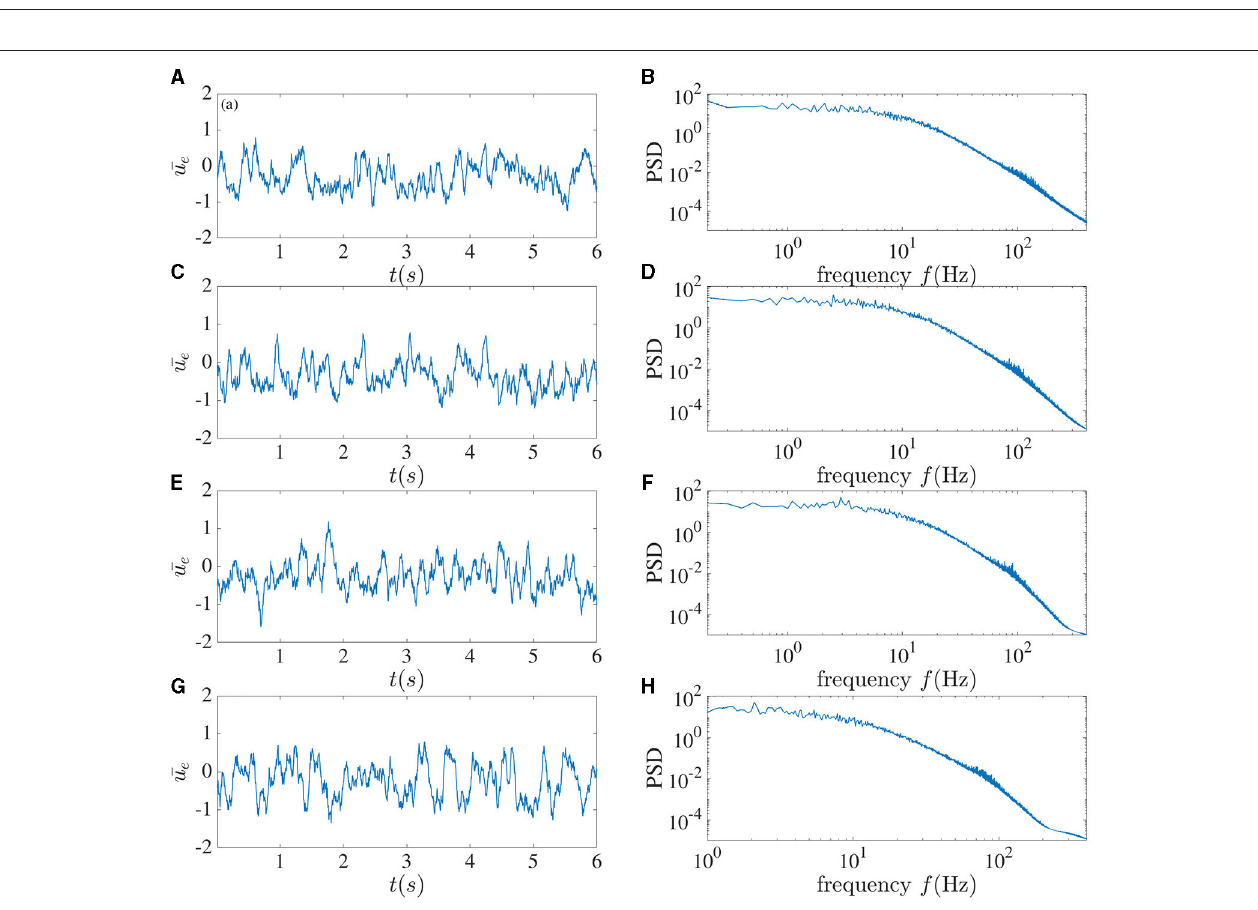
FIGURE 10 | Frequency-dependent complexity collapse. Network dynamics when an external sinusoidal stimulation is activated for 1 s from t Here the global feedback strength is κ